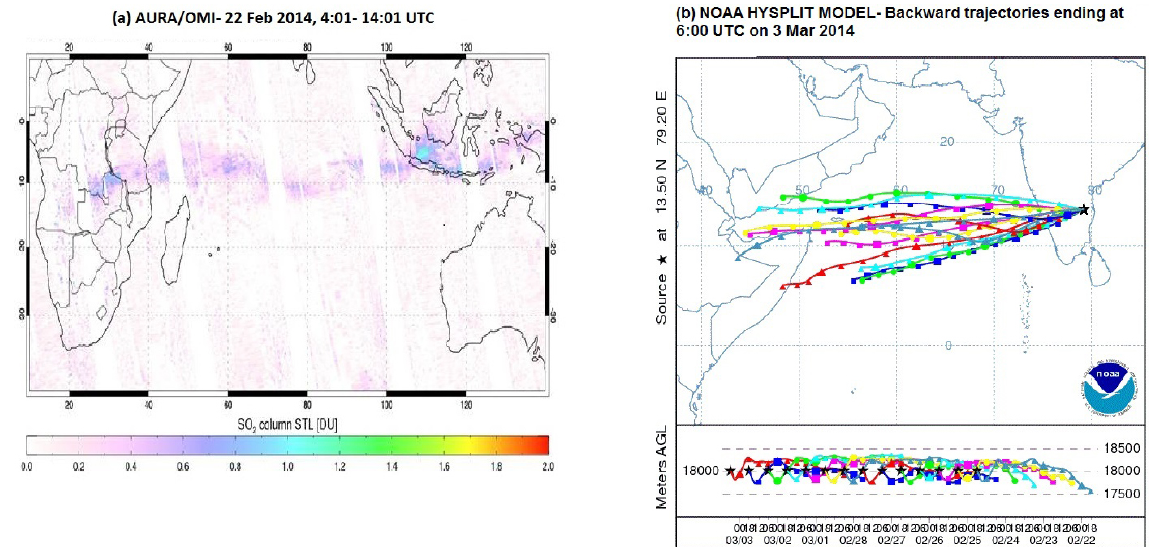
Figure 4. (a) Latitude–longitude image of OMI Aura stratosphere and troposphere layer vertical column SO 2 for the height region of 15– 20km on 22 February 2014 and (b) 168h back trajectory ending at 06:00UT on 3 March 2014 using the National Oceanic Atmospheric Administration (NOAA) HYSPLIT model.